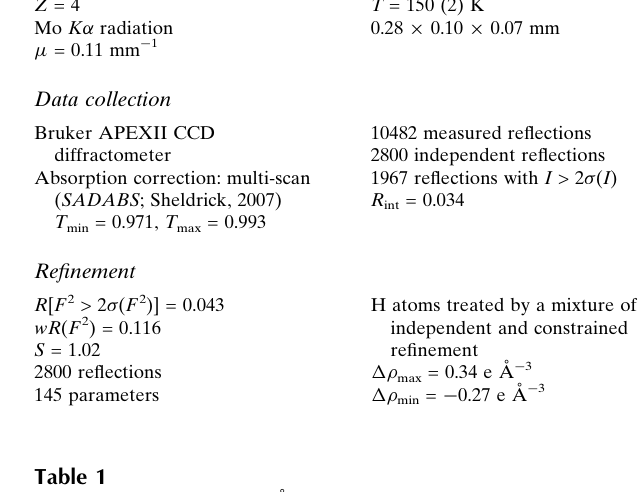
Hydrogen-bond geometry (A˚ , (cid:1)